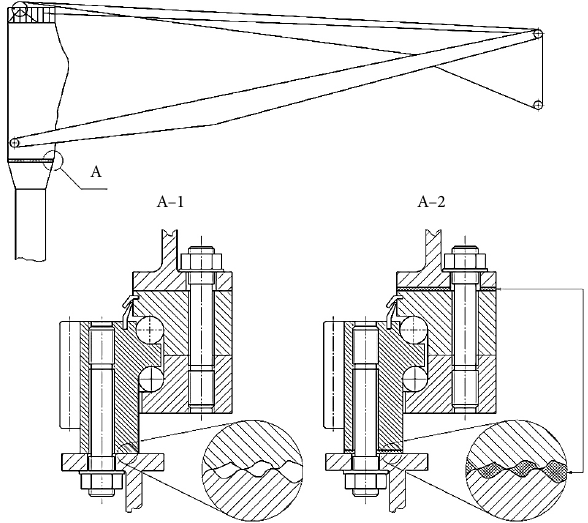
Figure 12. Use of epoxy composites for the maintaining the cargo crane on ship columns – simplified diagram of a slewing crane: A-1 – mounting of a rotary bearing in the traditional way; A-2 – bearing mount using a thin layer of